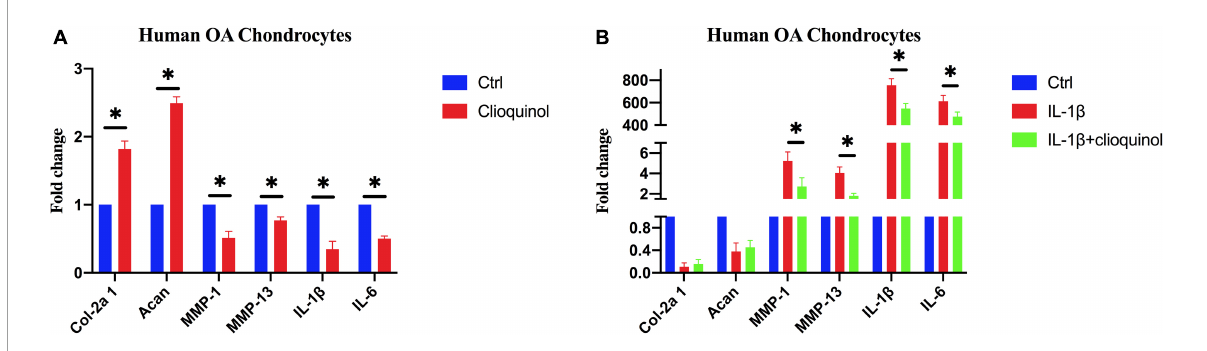
FIGURE3 The expression of osteoarthritic markers in human osteoarthritis (OA) chondrocytes after incubating with clioquinol (5 µ M) (A) , or IL-1ß (10 ng/ml), IL-1ß (10 ng/ml) + clioquinol (5 µ M) (B) , determined by PCR. All data are shown as the mean ± SD. ∗ p <